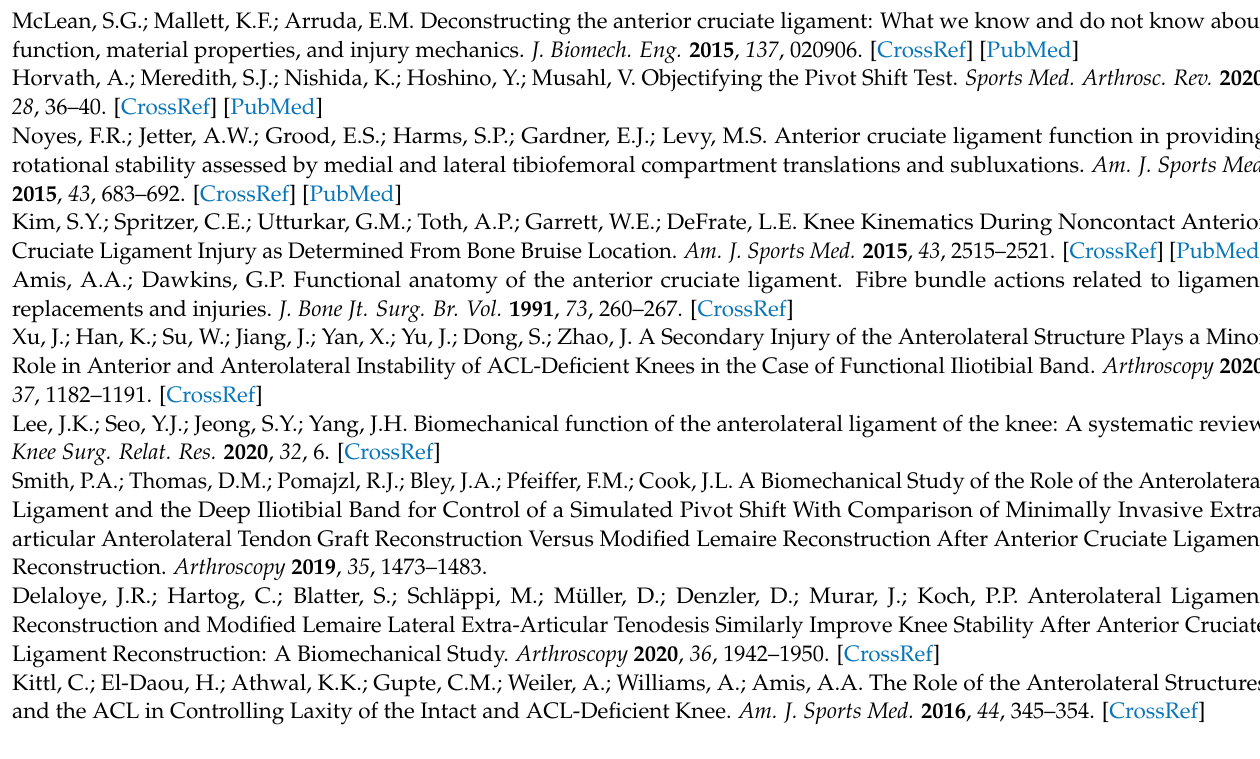
Figure S2.6: Comparison of the maximum strain values obtained in the current study,